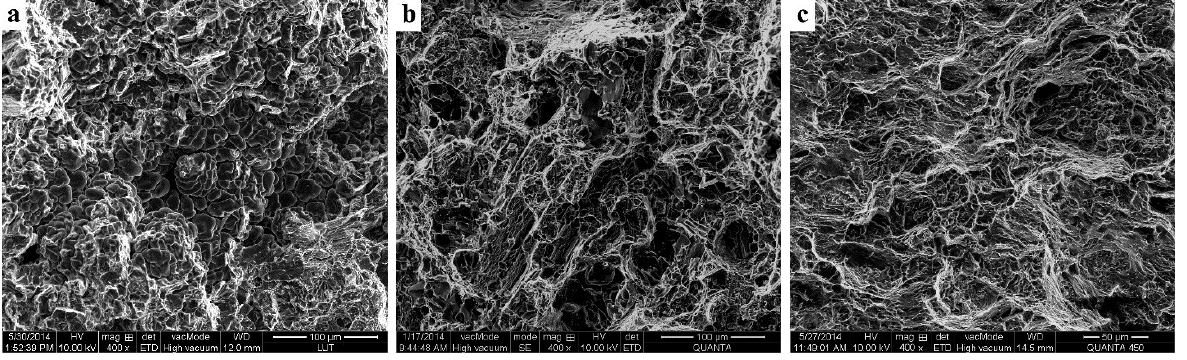
Figure 4. SEM fractographs of: ( a ) as-cast composite; ( b ) thixoforged composite and ( c ) thixoforged AM60B.